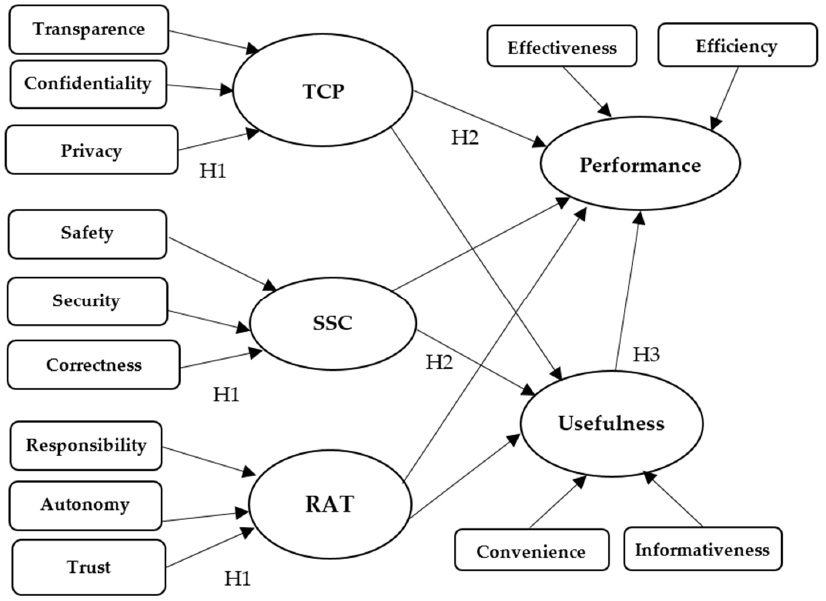
Figure 1. Conceptual model. Source: elaborated by the author based on [2,43–55].